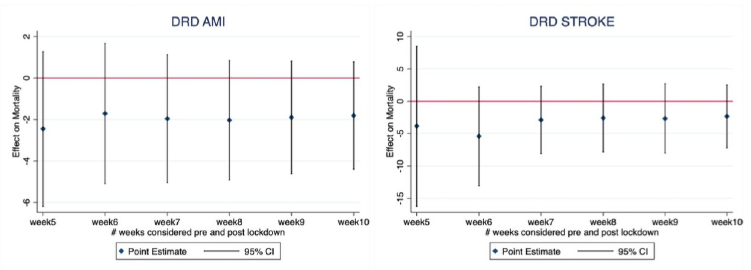
Fig 3. Coefficient (95% CI) indicating mortality difference post/pre lockdown in various time windows following implementation of the COVID-19 lockdown (March, 9 th 2020) versus the same event in the similar time windows in previous years (2019–18). Estimates derived from difference in regression-discontinuity design adopting a Firth logit